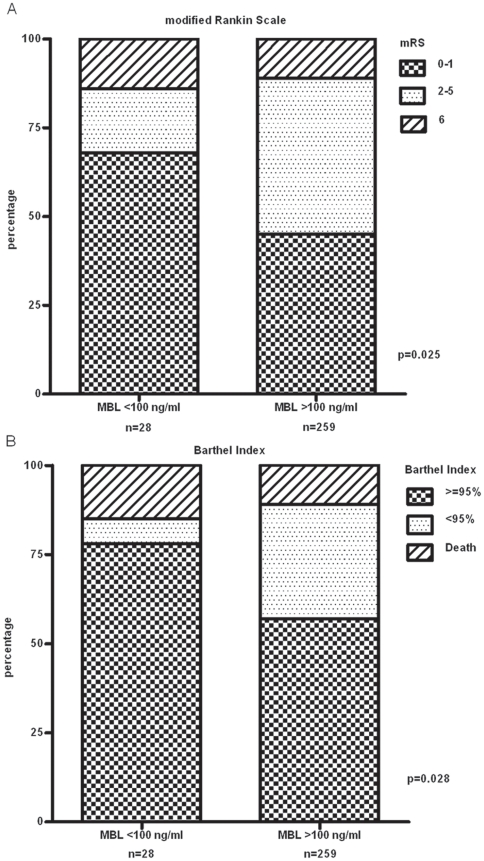
Association of MBL deficiency with functional recovery.Conservative treatment group: association of functional MBL deficiency (MBL<100 ng/ml) with functional recovery three months after ischemic stroke as assessed by (A) the modified Rankin Scale and (B) the Barthel Index.